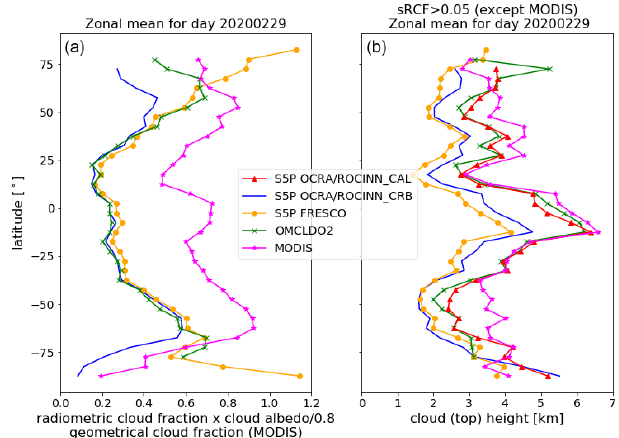
Figure 4. Zonal means on 29 February 2020. (a) Scaled radiomet- ric cloud fraction f rc , 0 . 8 of S5P OCRA/ROCINN_CRB version 1, S5P FRESCO version 1.3 and OMCLDO2, and geometric cloud fraction of MODIS. (b) Cloud height of the same data products, and in addition cloud-top height of S5P OCRA/ROCINN_CAL ver- sion 1. Here, pixels with f rc , 0 . 8 < 0 . 05 are excluded (not applicable to MODIS), as the cloud height becomes highly uncertain at a very low cloud fraction. Note that S5P OCRA/ROCINN automatically assigns a fill value to the cloud height when RCF < 0 .